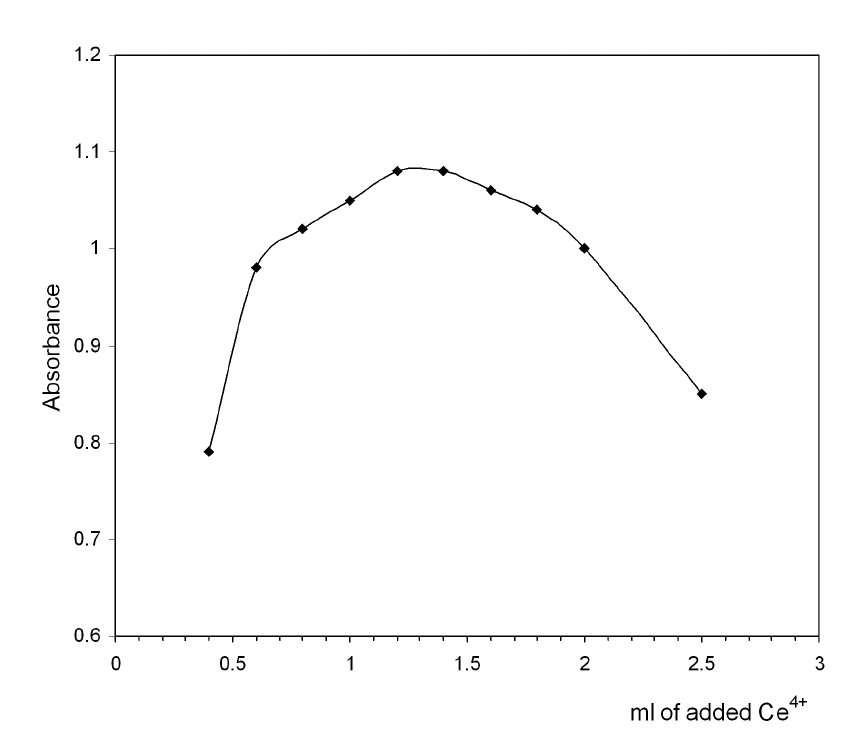
Fig. 3 Effect of added 3 × 10 − 3 M Ce 4+ on the intensity of the color produced during the reaction (7.0 µ g m1 − 1 DIL.HCl, 0.4-2.5 ml Ce 4+